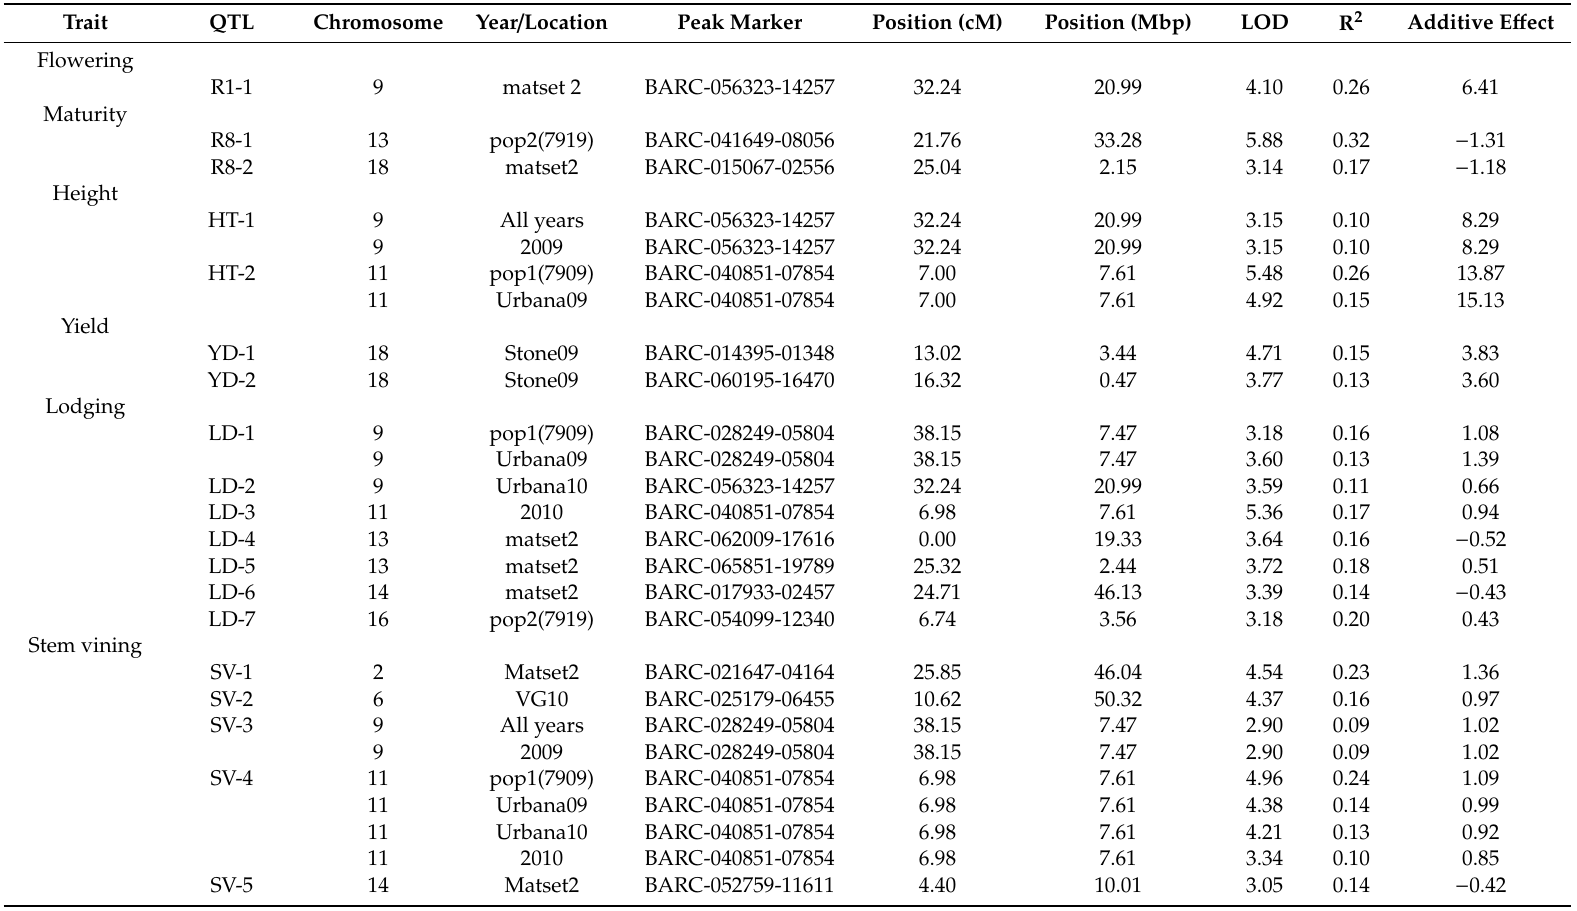
Table 2. Peak markers that exhibit the highest association for each quantitative trait locus (QTL) identified in this study. Year / location indicate the datasets in which the QTL is identified. The direction of additive e ff ects indicates the e ff ects of G. max alleles. Units used for phenotype measurement are flowering and maturity in days, height in cm, seed yield in kg ha − 1 , lodging on a scale of 1 (all plants are erect) to 10 (all plants are prostrate), and a stem vininess on a scale of 1 (typical indeterminate cultivar) to 5 (viney stem